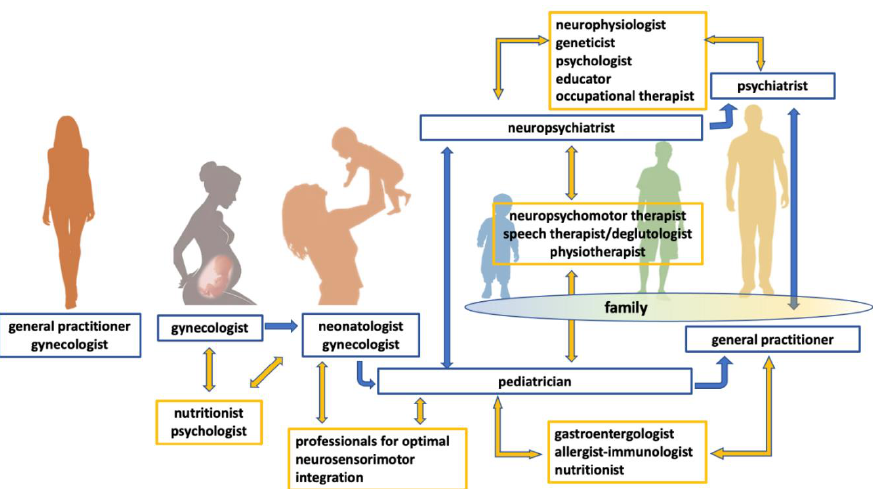
Figure 2. Mother’s health is the premise for a successful intrauterine life. During pregnancy, the gynecologist ensures the best control of risk factors and the enhancement of protective factors, largely related to proper maternal nutrition and supplementation. After birth, the baby–mother dyad is supported by the neonatologist–gynecologist duo. The qualified support for the well-being of the mother is integrated by neonatal care, which includes the best conditions of neurosensory-motor integration aimed at the physiological postnatal neuronal wiring. With variable times and modalities—mostly depending on the outcome of the pregnancy and the characteristics of the newborn—the child’s care is subsequently entrusted to the pediatrician, who provides suggestions for a positive physical and neuro-psychomotor development. In case of clinical abnormalities, the pediatrician prompts diagnostic pathways and early interdisciplinary interventions based on clinical and laboratory findings. In the event of motor and/or socio-communicative abnormalities, the pediatrician consults the neuropsychiatrist, who shall consider whether to include standardized diagnostic tools for ASD in the clinical assessment. The diagnosis of ASD is followed by further diagnostic evaluations (neurophysiologist, geneticist), functional assessment, and timely psychoeducational evidence-based interventions. The neuropsychiatrist orchestrates the cooperation of numerous professionals (psychologist, educator, occupational therapist), monitors the results, and tailors the supports according to the evolving skills and needs. In parallel with the neuropsychiatrist, the pediatrician prompts a clinical assessment according to the expected comorbidities in ASD, involving in particular gastroenterologist, allergist-immunologist, and nutritionist. A close collaboration with the neuropsychiatrist allows the best integration of physical and neuropsychiatric aspects, involving at the same time professionals linked both to the pediatric and the neuropsychiatric sides. The transition towards adulthood requires a handover on both levels of intervention, from the pediatrician to the general practitioner for the biological features, and from the neuropsychiatrist to the psychiatrist for the psychiatric sphere. The connection between the two levels (body and mind) is maintained even in adulthood. It should be noted that the above described structured model acquires worth and meaning if it places in the center the person with ASD and his/her family, as the main stakeholders of a flexible model, able to adapt to the evolving needs and favoring the highest level of feasible well-being.